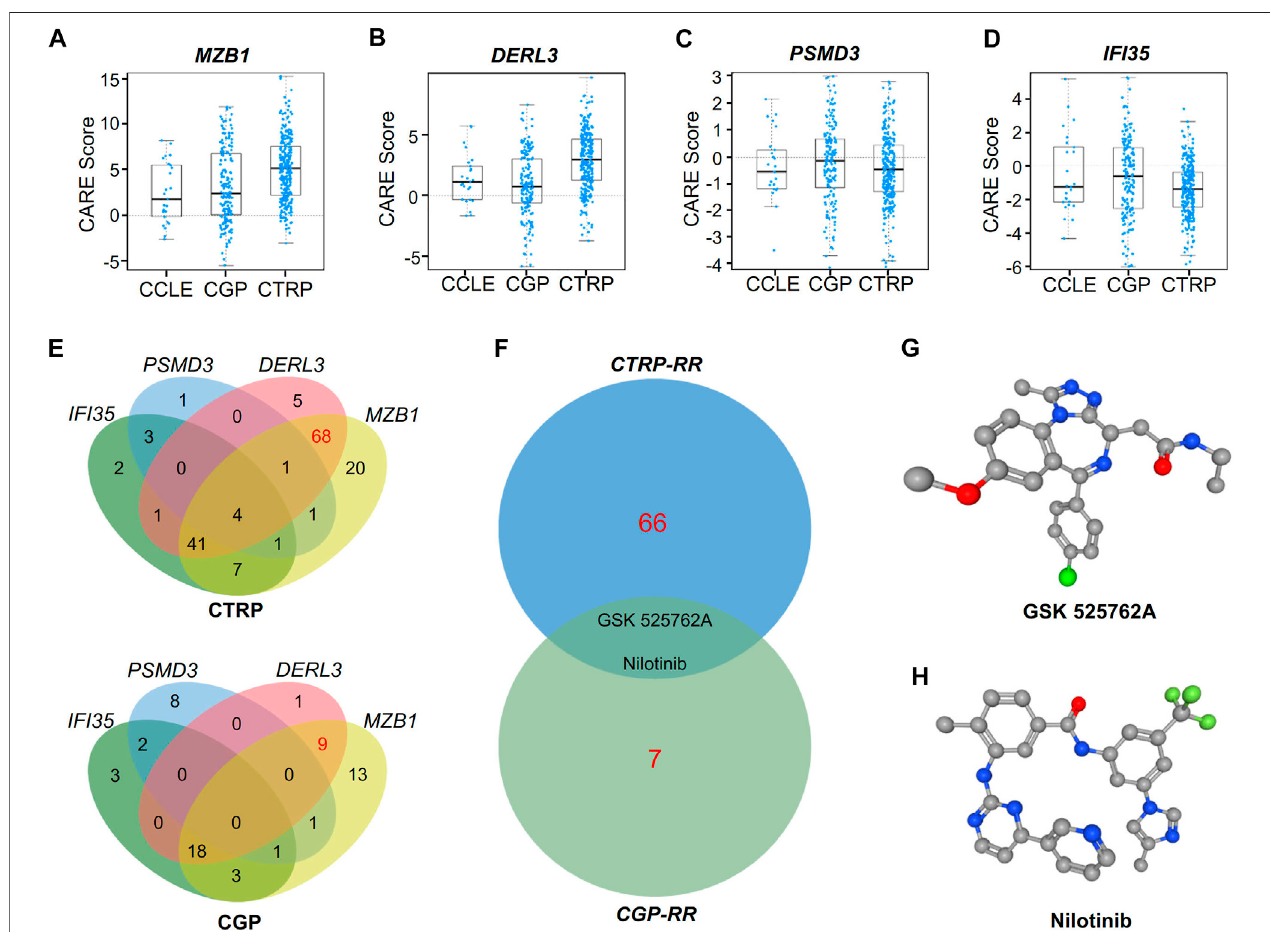
FIGURE 7| CARE analysisfor hub genesin responseto targeted therapy. (A – D) CARE analysisof the resistance module genes MZB1 (A) and DERL3 (B) and the responsemodulegenes PSMD3 (C) and IFI35 (D) inthedatabasesoftheBroadInstituteCancerCellLineEncyclopedia,theCTRPandtheGenomicsofDrugSensitivity in Cancer (CGP). (E) Venn diagram showing the overlap of target drugs affected by MZB1 , DERL3 , PSMD3 , and IFI35 in the CTRP and CGP databases. (F) Venn diagram showing the potential target drugs for RR patients, i.e., GSK525762A and nilotinib. (G – H) Three-dimensional (3D) structures of GSK525762A (G) and nilotinib (H)